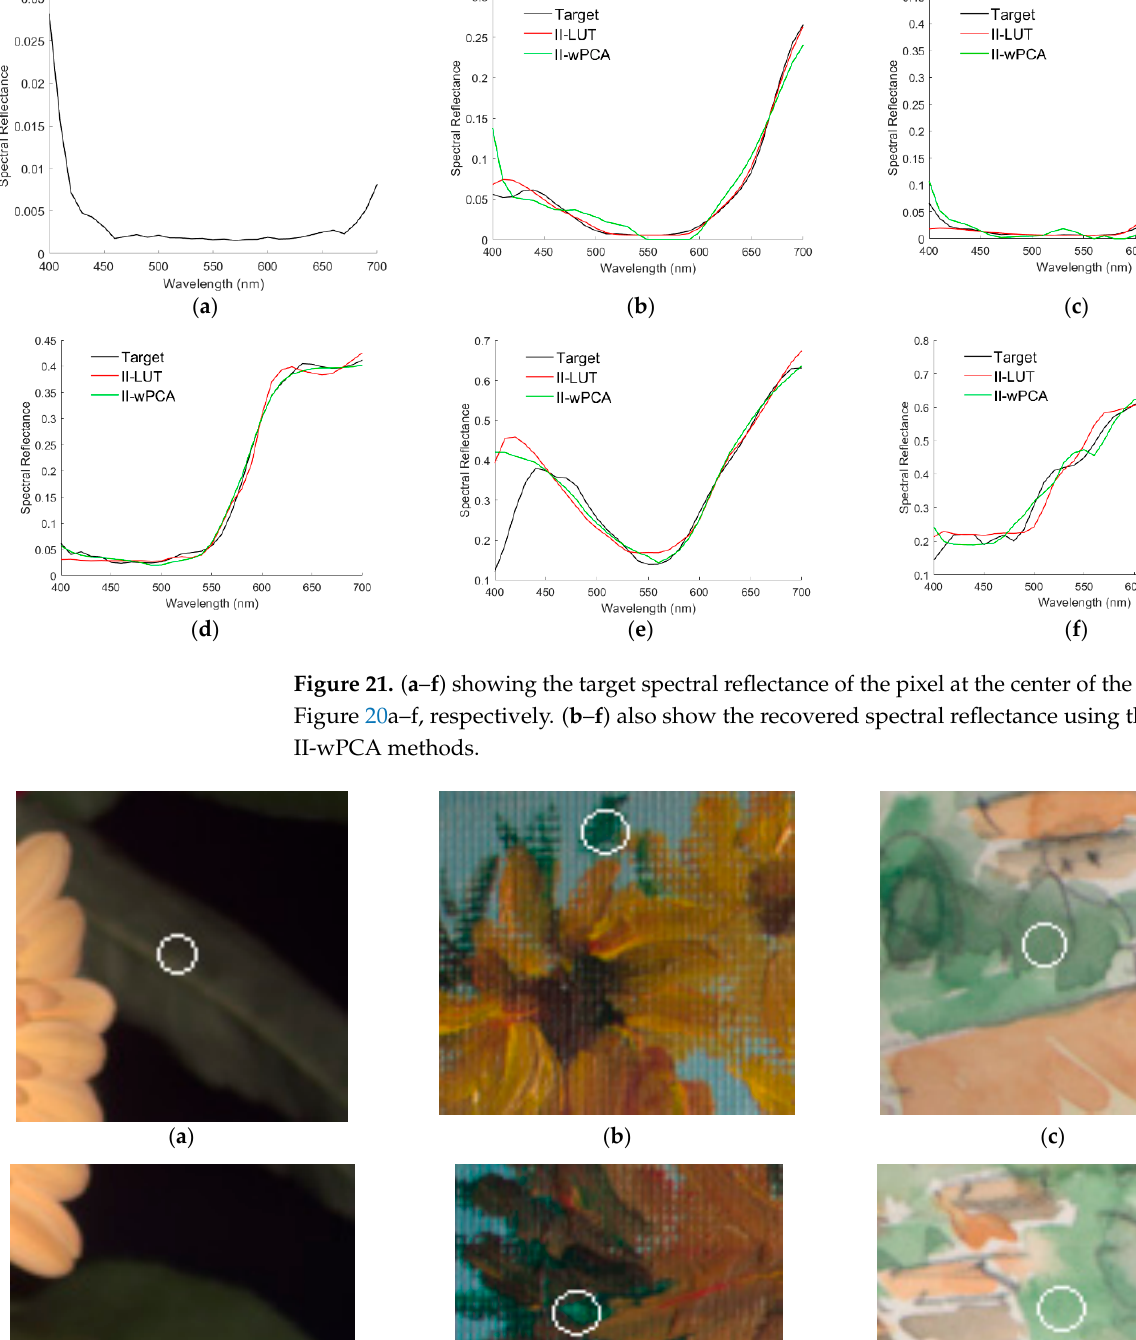
Figure 20. ( a ) Original image of Figure 15d. ( b – f ) showing enlarged images on the deep purple, red, orange, purple and yellow flowers in ( a ), respectively. The center of the white circle was an example pixel showing the recovered spectral reflectance, except for the white circle in the upper left corner.